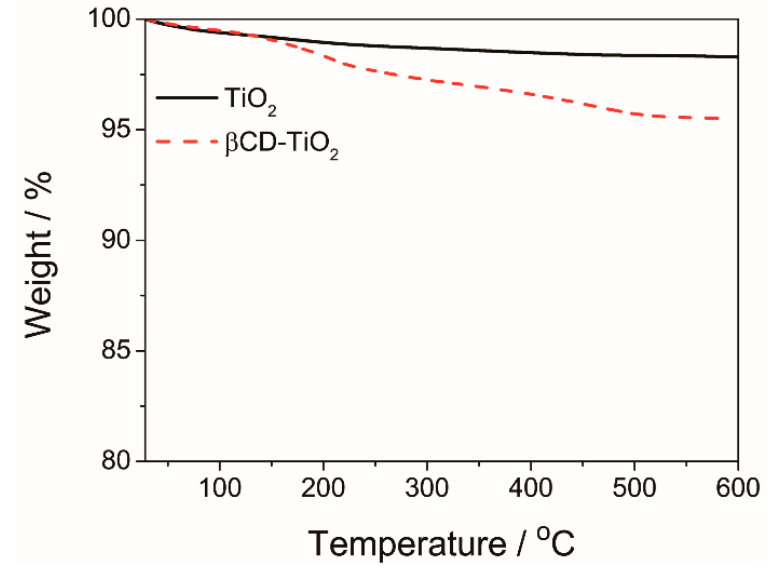
Figure 4. Thermogravimetric analysis (TGA) of TiO 2 and β -CD-TiO 2.